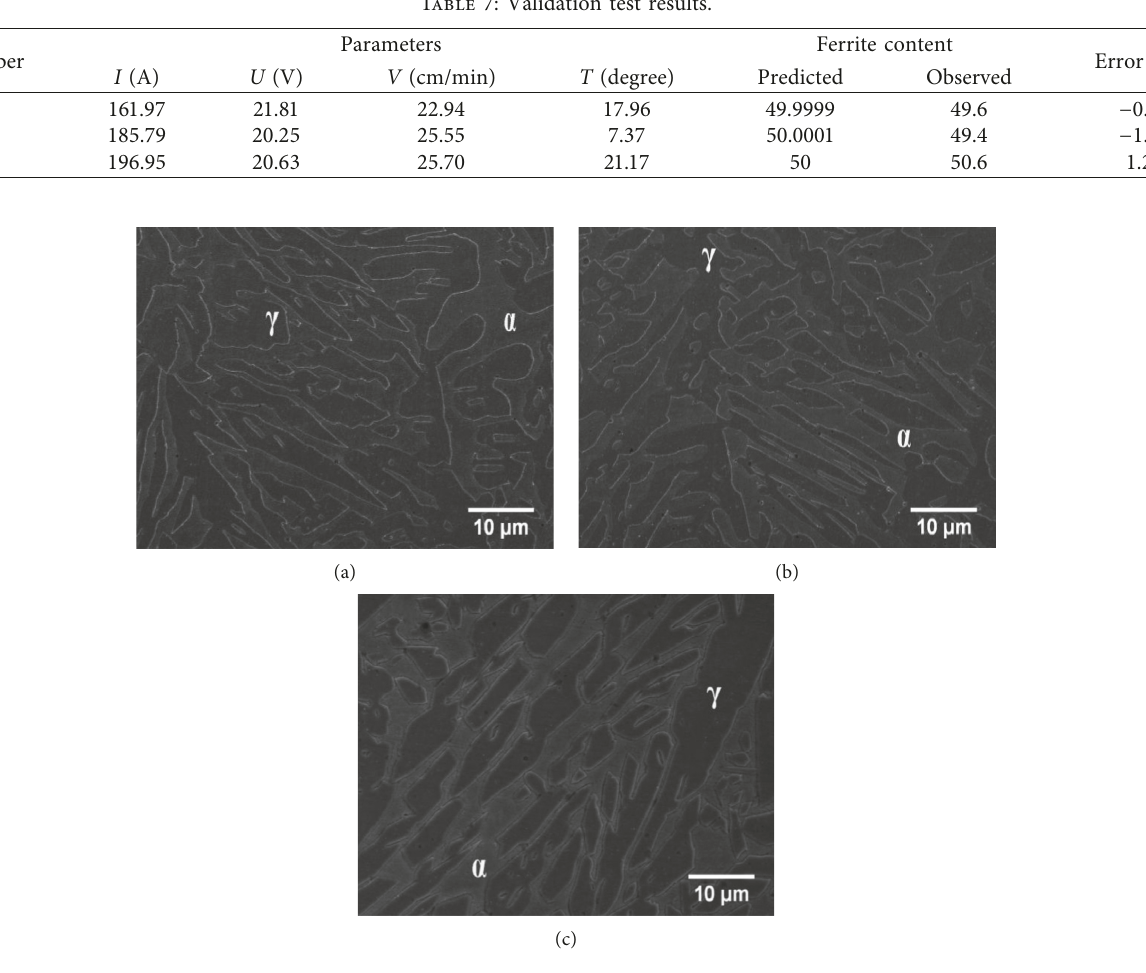
Figure 5: SEM micrographs of the validation